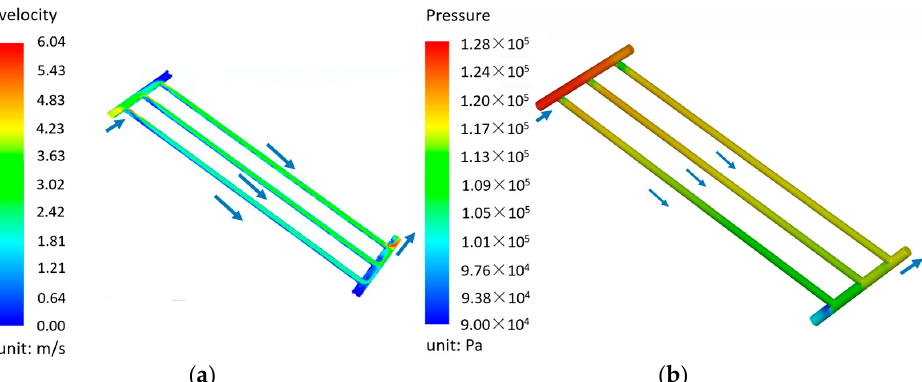
Figure 10. Velocity of fluid and pressure drop of the redesign scheme at the end of pulse length 100 s (entrance collimator): ( a ) Velocity of cooling water in the cooling tube; ( b ) pressure drop along the cooling tube.